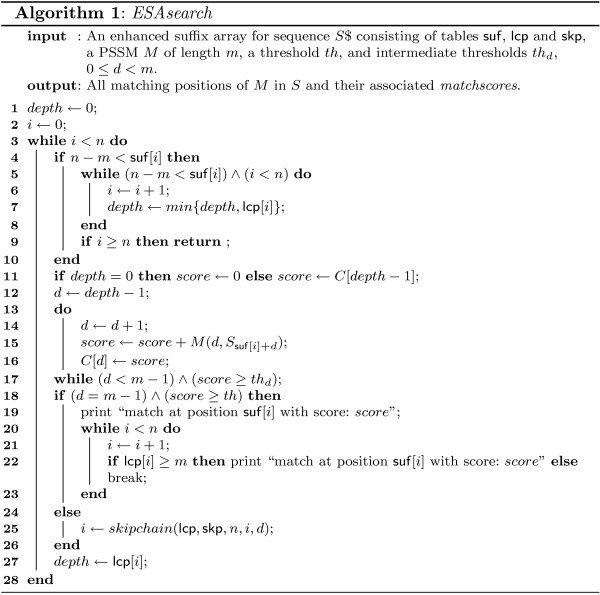
Algorithm ESAsearch. The algorithm ESAsearch formulated in pseudocode. See text for detailed explanations of the used notions.